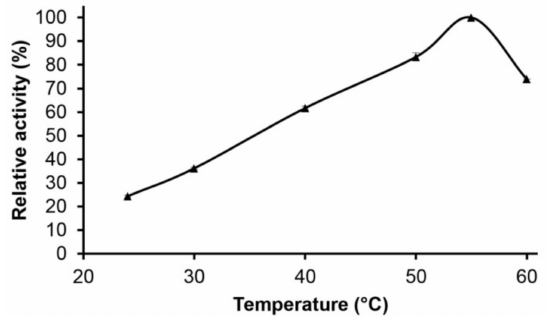
Figure 5. E ff ect of temperature on activity of purified Pc Xyn11A under a standard enzyme assay